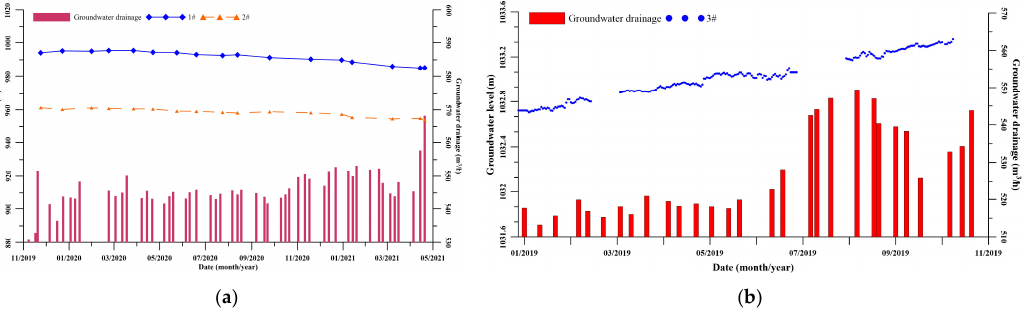
Figure 6. Temporal variations of groundwater level under groundwater drainage in Hetaoyu Coal Mine. ( a ) Luohe aquifer (1#) and mixed groundwater level (2#). ( b ) Huanhe aquifer (3#).